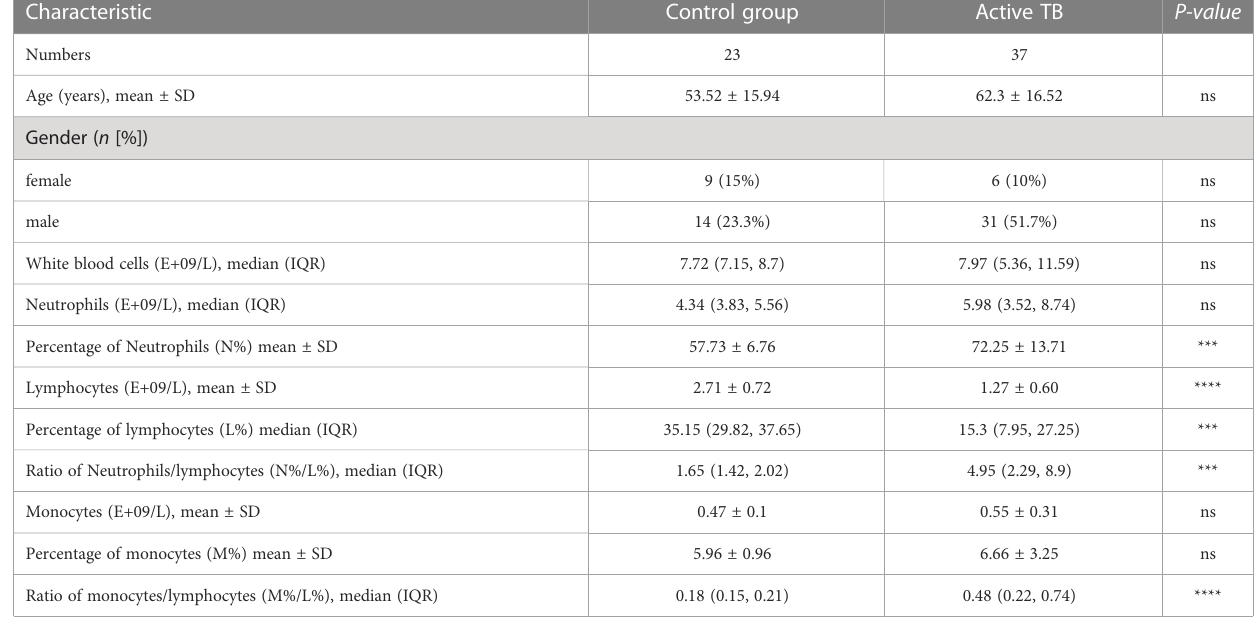
TABLE 2 Characteristics and white blood cell classi fi cation parameters of active TB patients and healthy individuals enrolled in this study.